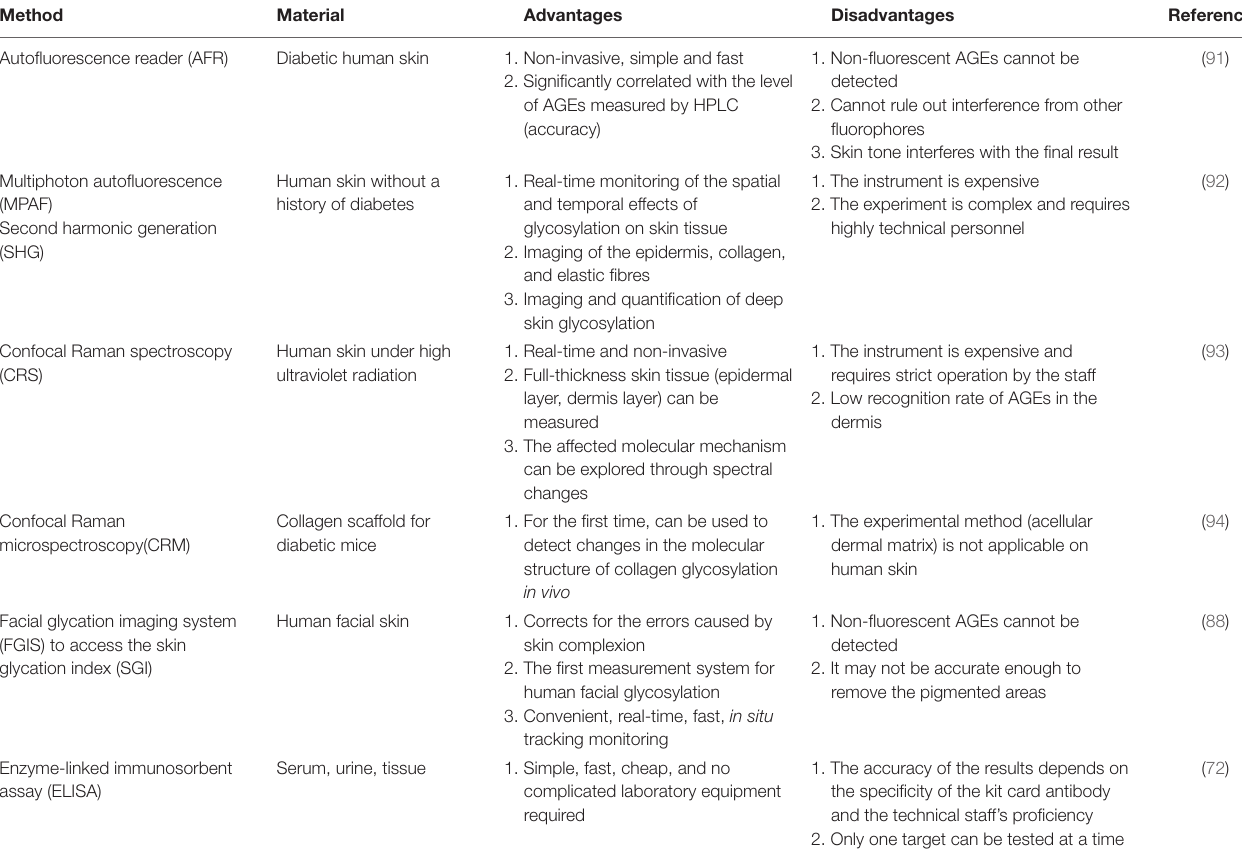
TABLE 2 | Different methods for measuring the content of advanced glycation end products (AGEs) in human skin and their advantages and